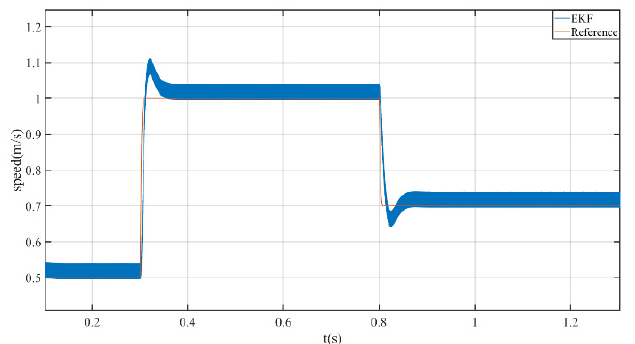
Figure 11. Experimental diagram.